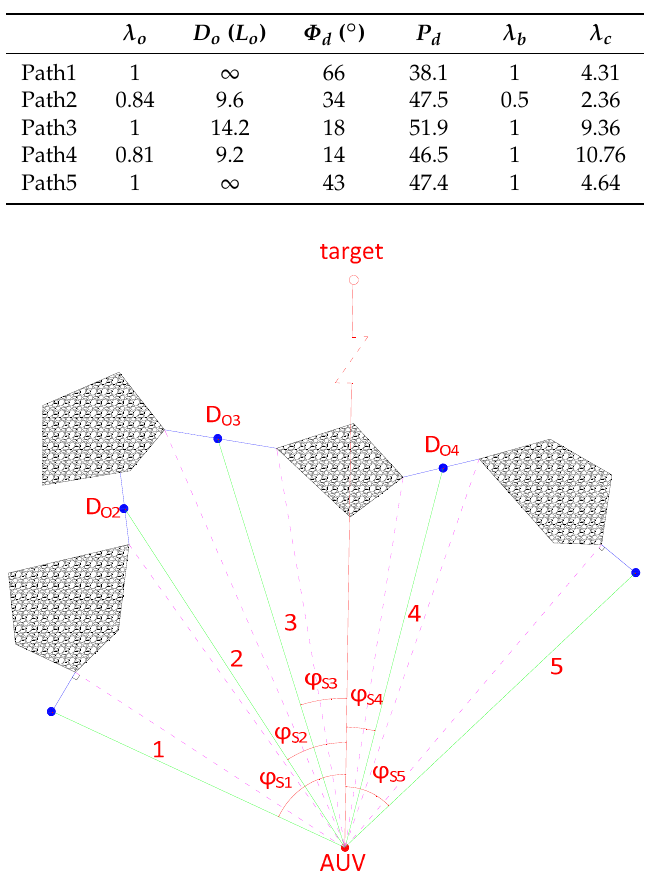
Figure 10. Dense obstacles environment voidance.